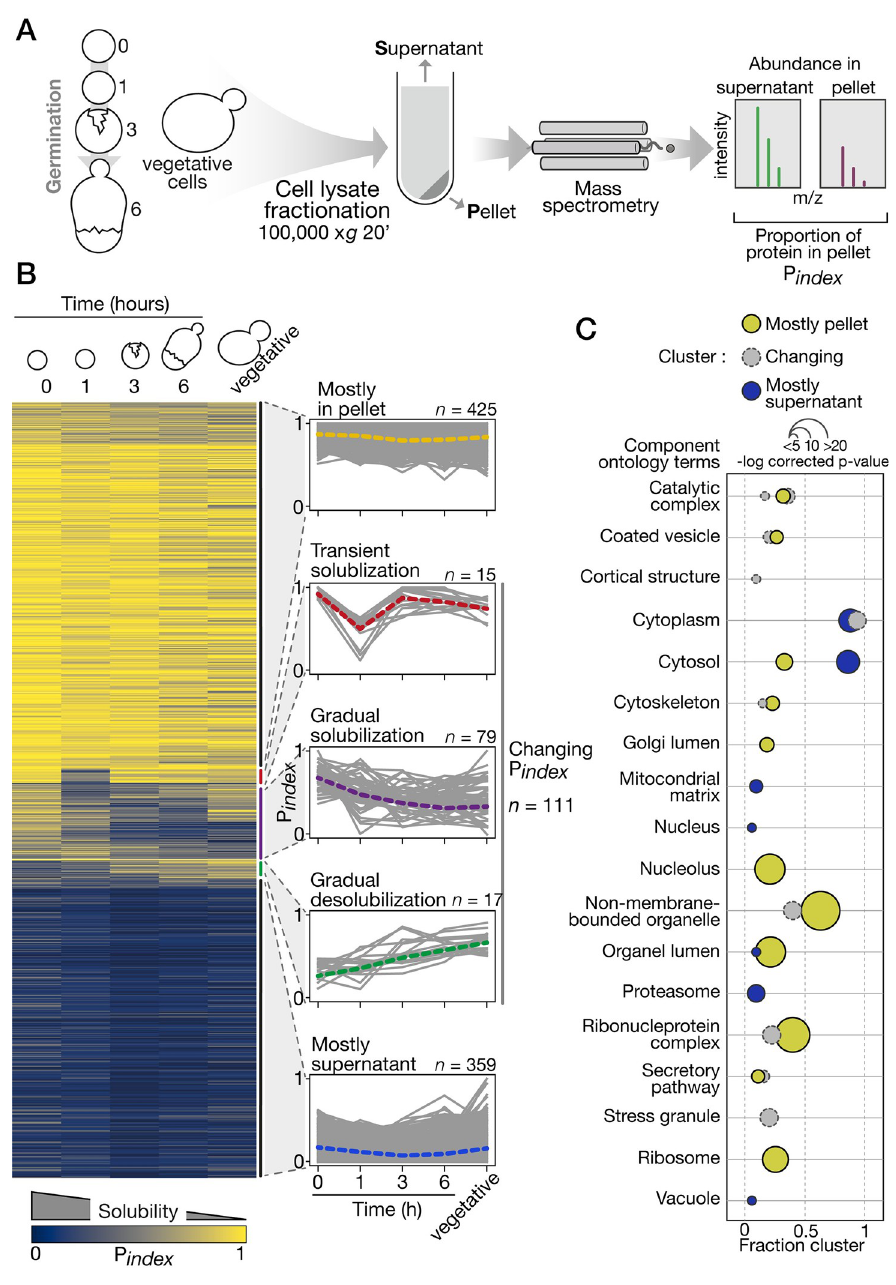
Fig 2. Proteome-wide change in protein solubility during germination. (A) Solubility measurement by LC-MS/MS estimates the proportion of each protein in the pellet (P index ) at each major time point sampled during germination. The experiment was performed in triplicate for all time points. (B) Right, P index values in the course of germination show, from top to bottom, proteins consistently found in the pellet, that transiently solubilize, that gradually solubilize, that gradually accumulate in the pellet, and that are consistently found in the supernatant. Left, individual P index trajectories for each cluster determined by hierarchical clustering. The dotted line is the median trajectory for each cluster. (C) GO term analysis focused on cellular component terms. Terms enriched for each cluster (Mostly in pellet, Changing P index , and Mostly supernatant) are shown as bubble plots. Colors refer to the cluster, position on the x-axis indicates the portion of the proteins in a cluster assigned to a GO term, and size of the bubble is scaled to the -log (p- values). See S2 Fig for additional details. The data underlying this figure can be found in S2 Datasheet. GO, gene ontology; LC-MS/MS, liquid-chromatography-coupled tandem mass